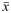
Model person and forces acting on m.The thick horizontal line is the platform. 0 denotes the origin of the non-moving reference outside the platform. x¯ is the position of the midpoint between the feet in this reference frame. x¯ and z¯ change with time.